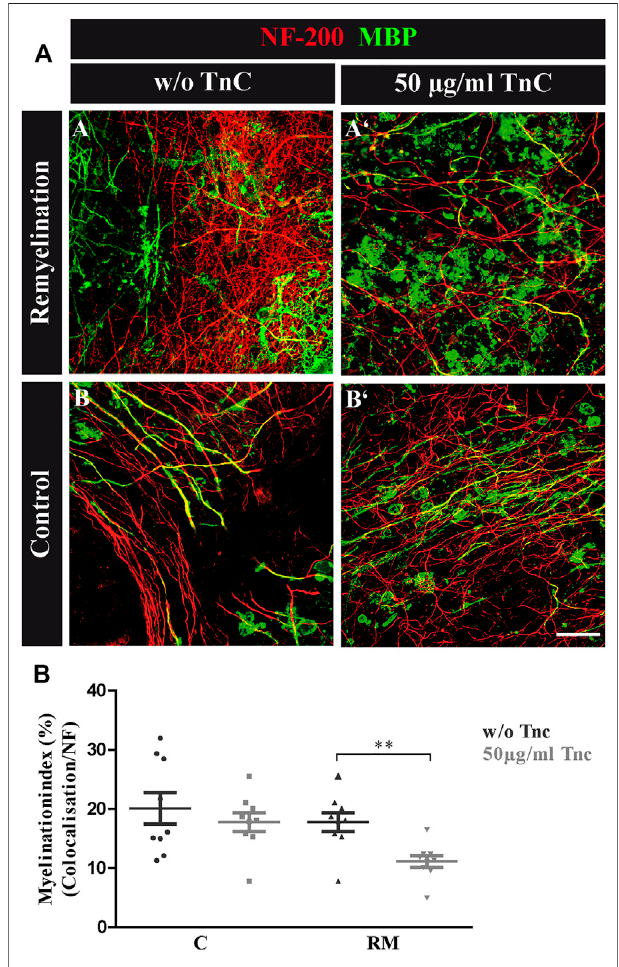
FIGURE 3 | (A,B) Tnc inhibits remyelination in cerebellar slice cultures . (A,A 9 ,B,B 9 ) Exemplary cerebellar explants cultivated in the absence (A,B) or presence (A 9 ,B 9 ) of Tnc. Slices were stained for NF-200 and MBP. Tnc- treated remyelinated cultures displayed myelin membranes that did not wrap the axons throughout the whole cerebellar slice. Scale bar: 20 μ m. (B) Evaluation of myelination index, de fi ned as the proportion of colocalized area amongtheareasofcompleteneuro fi lamentstaining.Theseresultsindicatean impaired remyelination in Tnc-treated cultures. Data are presented as mean ± SEM, and statistical signi fi cance was assessed using an unpaired two-tailed Student ’ st-testforeach group (remyelinated andcontrol).Sixindependent (N = 6) experiments were performed, and three explants ( n = 3) were analyzed per experiment for each condition.